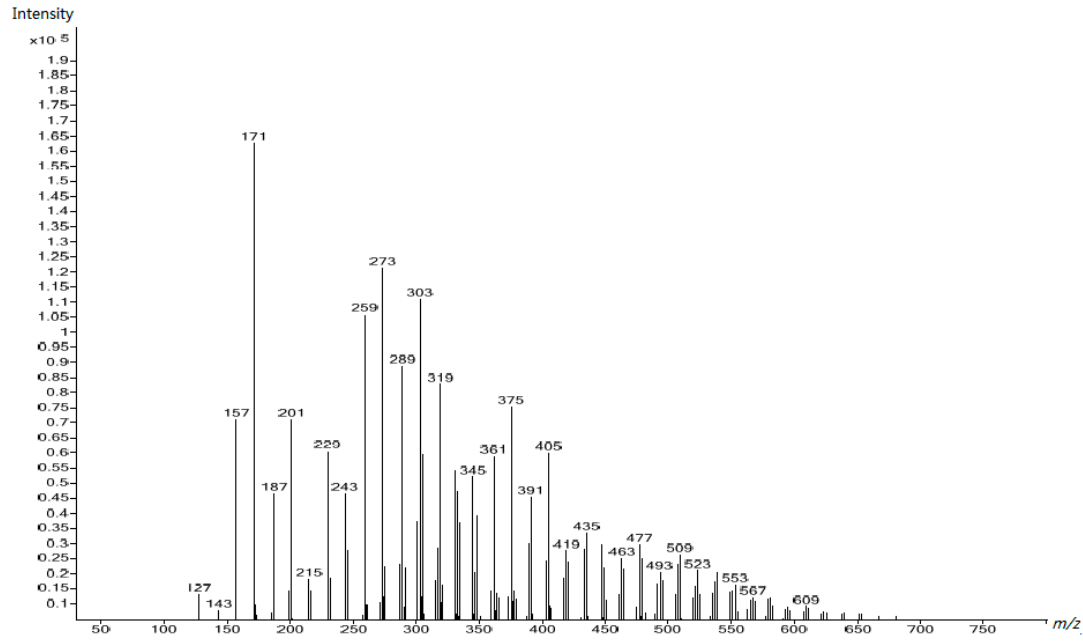
Figure 10. The ESI–MS spectrum of UF-3.